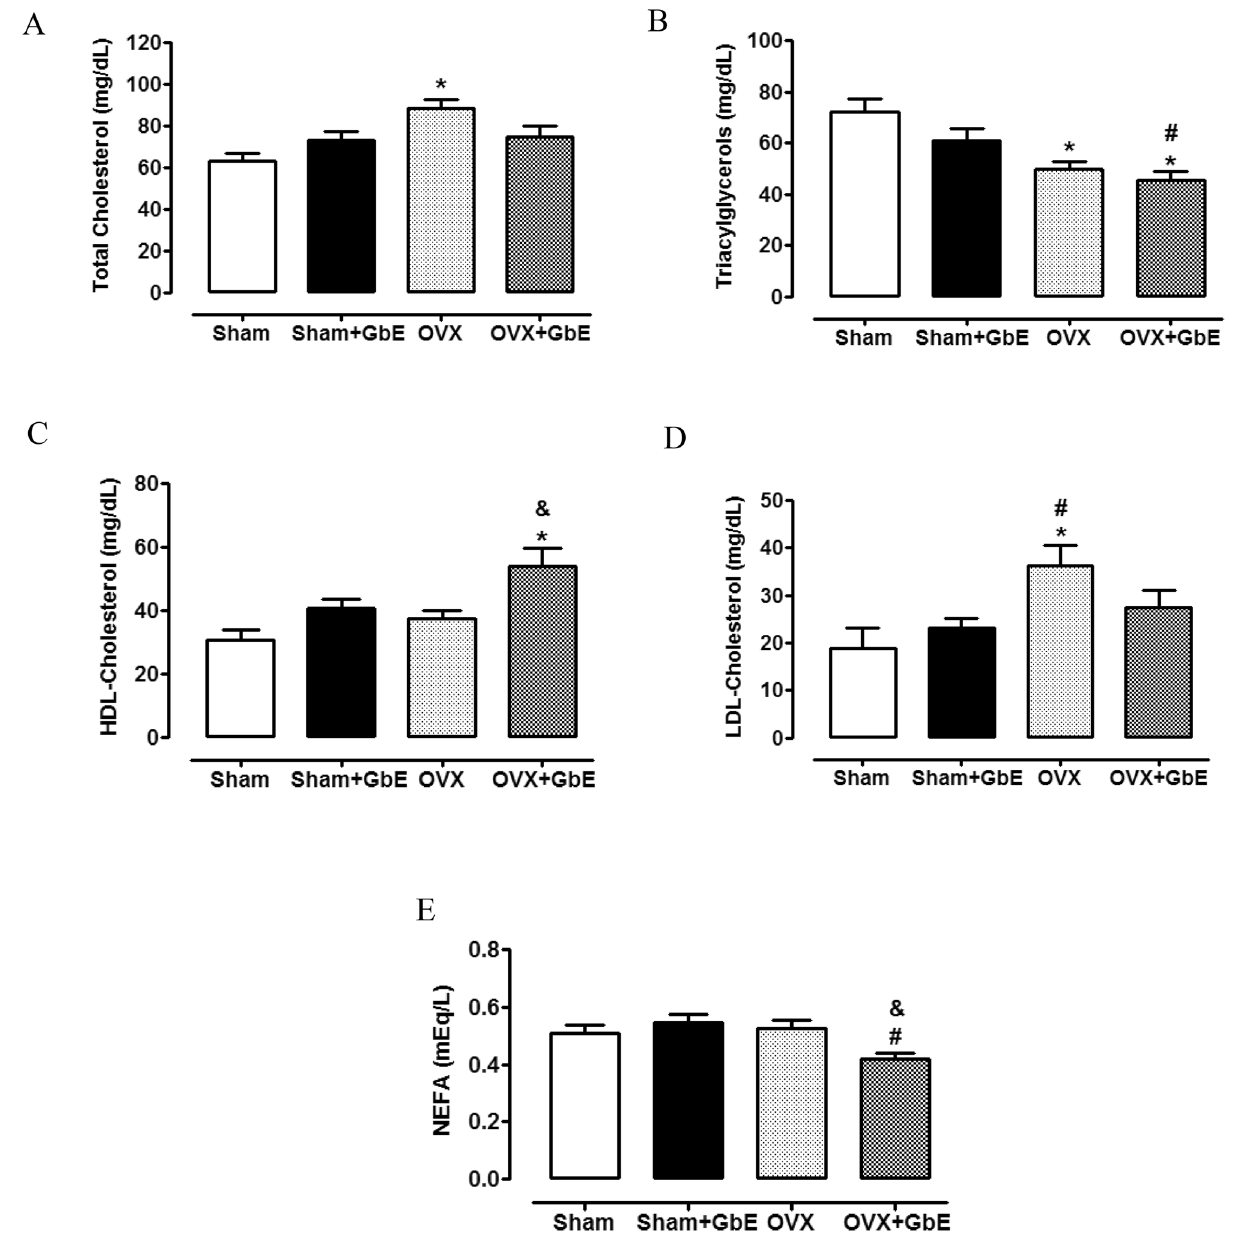
Figure 5. Lipid profile after GbE treatment. ( A ) Total cholesterol, ( B ) triacylglycerols, ( C ) HDL-Cholesterol, ( D ) LDL-cholesterol and ( E ) NEFA (mEq/L) of Sham (n = 10–11), Sham + GbE (n = 13–15), OVX (n = 11–13) and OVX + GbE (n = 12–15) groups. * p ≤ 0.05 vs. Sham; # p ≤ 0.05 vs. Sham + GbE; & p ≤ 0.05 vs. in relation to the Sham (33%, p = 0.006) and the Sham + GbE (41%, p = 0.001) groups. The OVX group exhibited 64% ( p = 0.006) and 42% ( p = 0.018) increases of carcass fat content [F (3,21) = 6.552, p = 0.003], in comparison to the Sham and the Sham + GbE groups, respectively (Fig. 4C). Considering carcass protein content (Fig. 4D), the OVX + GbE group had an increment [F (3,21) = 4.263, p = 0.019] of 26% ( p = 0.034) and 25.5% ( p = 0.022), in com- parison to the Sham and the OVX groups, respectively. At the 14th day of the phytotherapy treatment, OVX rats tended to present a higher body weight [F (3,21) = 3.046, p = 0.041] in relation to Sham + GbE group ( p = 0.057), but GbE did not restore this parameter in the OVX + GbE group (Fig. 4E). GbE improves hormone levels and lipid profile of OVX rats. The measured serum parameters are illustrated in Table 1. No significant differences among the groups were observed in glycemia [F (3,57) = 1.148, p = 0.338], fasting insulin levels [F (3,43) = 0.678, p = 0.571], HOMA-IR [F (3,44) = 0.417, p = 0.742], HOMA-β [F (3,42) = 0.570, p = 0.638] and TNF-α levels [F (3,44) = 0.076, p = 0.972]. However, leptin levels [F (3,44) = 4.109, p = 0.012] were 139% higher in the OVX group in comparison to the Sham + GbE group ( p = 0.006). Addition-